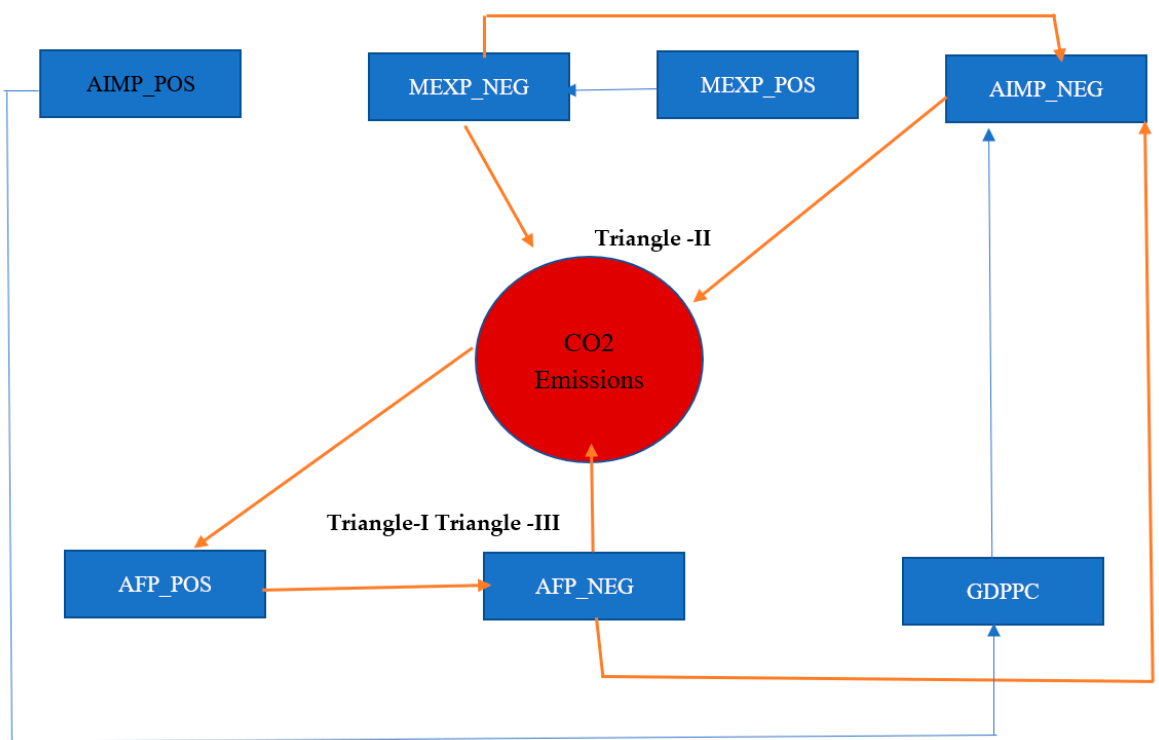
Figure 3. Granger casualty estimates. Note: CO 2 shows carbon emissions, AIMP_POS and AIMP_NEG shows positive and negative shocks in arms imports, AFP_POS and AFP_NEG shows positive and negative shocks in armed forces personnel, MEXP_POS and MEXP_NEG shows positive and negative shocks in military expenditures, and GDPPC shows GDP per capita.